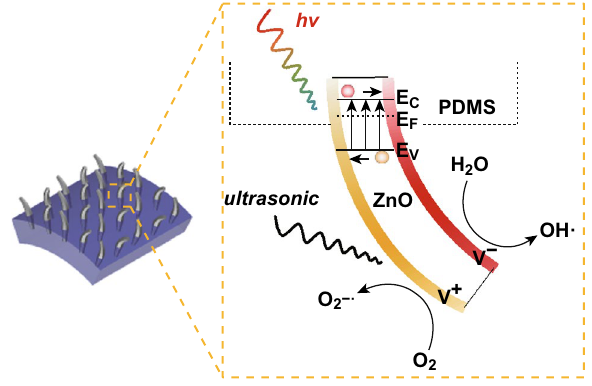
Fig. 8 Schematics of a ZP film attached to a glass rod and b floating ZP film. Degradation profiles of the MB dye (at 667 nm) c without UV light irradiation and d with UV light irradiation Fig. 9 Schematics of the piezo-photocatalytic